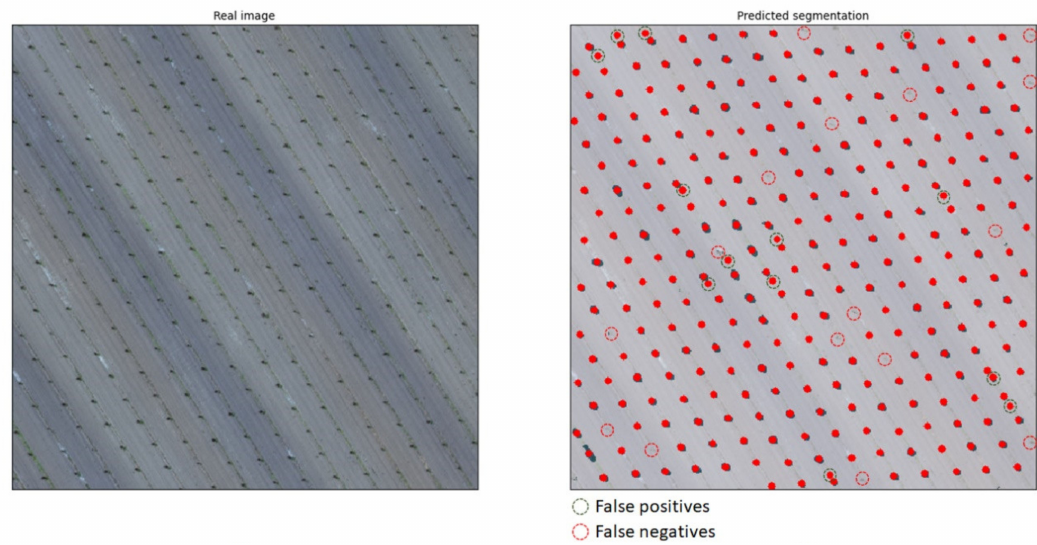
Figure 9. Undersampled orthomosaic of an orchard with young trees featuring small-sized canopies ( left ) and the segmentation predicted by the model ( right